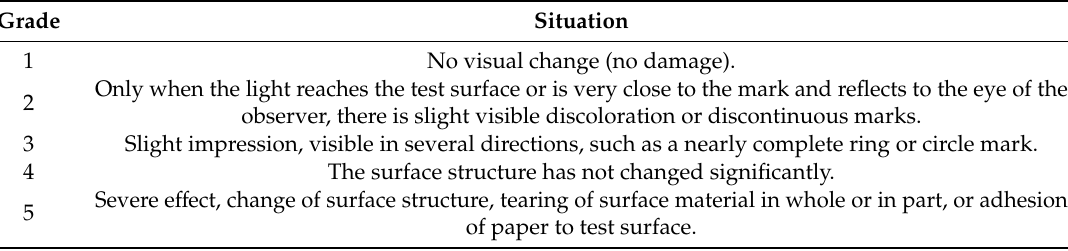
Table 7. Classification of liquid resistance of furniture paint film.